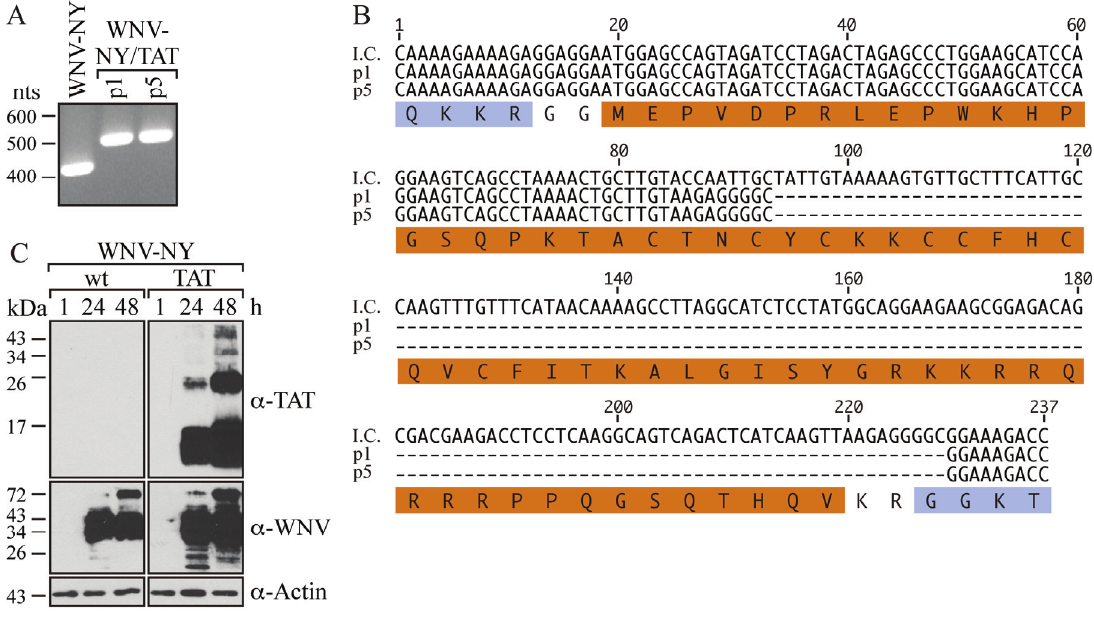
Figure 2. Characterization of WNV-NY/TAT. ( A ) RT-PCR analysis. RNA extracted from passage 1 (p1) and passage 5 (p5) WNV-NY/TAT-infected cells at 48 h post-infection was used as a template for RT-PCR amplification of the WNV C/CA region (WNV nts 97-500). RNA extracted from cultures infected with wild-type WNV-NY was used as a positive control. DNA molecular size standards (in nts) are indicated on the left; ( B ) Sequences. The p1 and p5 PCR products (Panel A) were sequenced by GeneWiz. The sequence encompassing the TAT(1-67) insertion in the WNV-NY/TAT infectious clone (I.C.) is shown at the top. The amino acid sequence is shown below with the WNV residues indicated in blue and the TAT(1-67) residues in orange; ( C ) Immunoblots. Vero monolayers were infected (MOI = 0.05) with WNV-NY or WNV-NY/TAT p0. Cell lysates prepared at the indicated times (h) were subjected to SDS-PAGE and immunoblot analysis with anti-TAT (top), anti-WNV (middle), or anti-actin (bottom) antibodies. Protein molecular size standards (in kilodaltons) are indicated on the